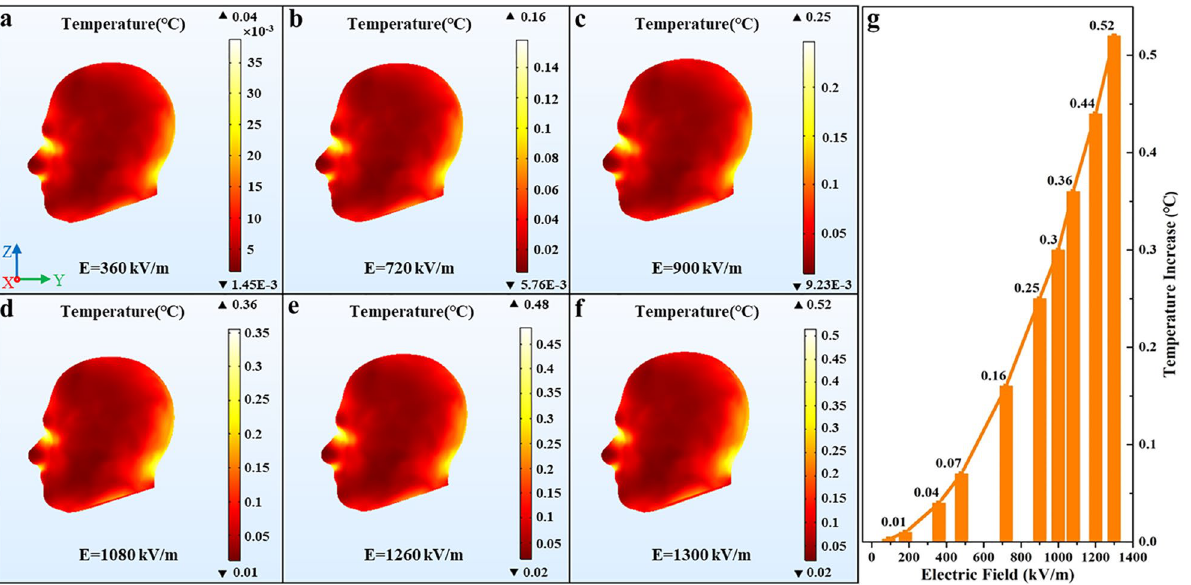
Figure 4. The temperature distribution in the human head and the variation curve of the temperature increase with different pulse field intensity. ( a ) E = 360 kV/m, ( b ) E = 720 kV/m, ( c ) E = 900 kV/m, ( d ) E = 1080 kV/m, ( e ) E = 1260 kV/m, ( f ) E = 1300 kV/m, ( g ) the variation curve of the temperature increase. We used COMSOL Multiphysics software, version 5.4 (https:// www. comsol. com/ comsol- multi physi cs) for simulation results (Images a – f ) and Origin software, version 8.0 (https:// www. origi nlab. com/ index. aspx? go= Produ cts/ Origin) for data analysis (Image g ).